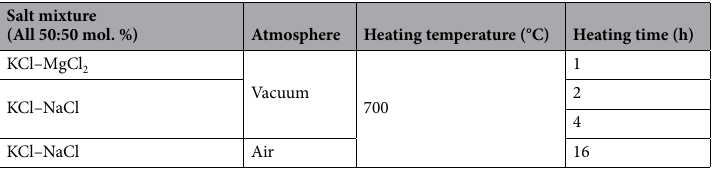
Table 1. A summary of experimental conditions for samples used in this